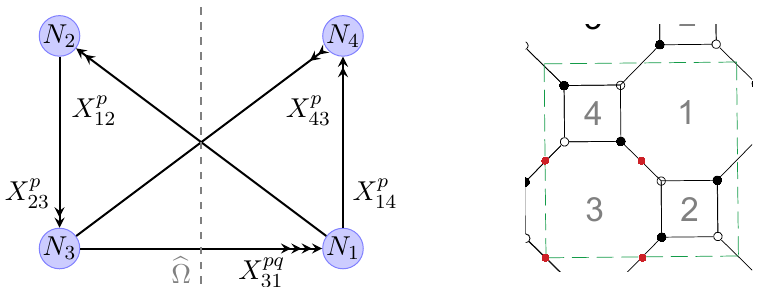
Figure 22. The orientifold projection b (cid:10) of C = Z 0 on the right.